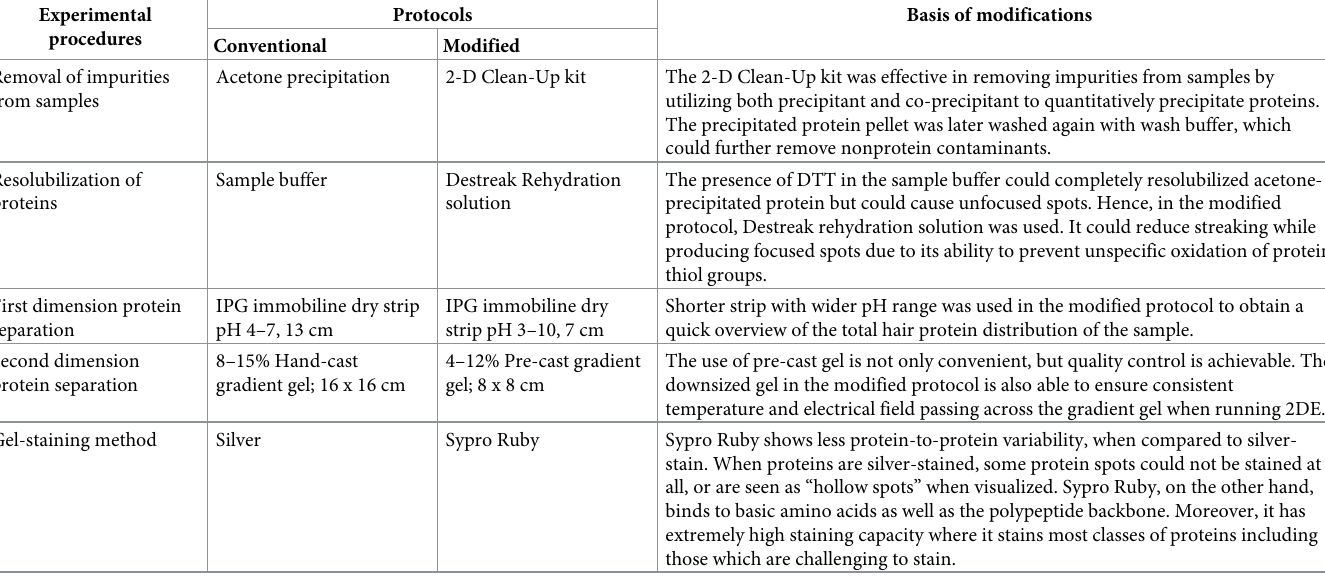
Table 2. Overview of the different experimental procedures used in both conventional and modified